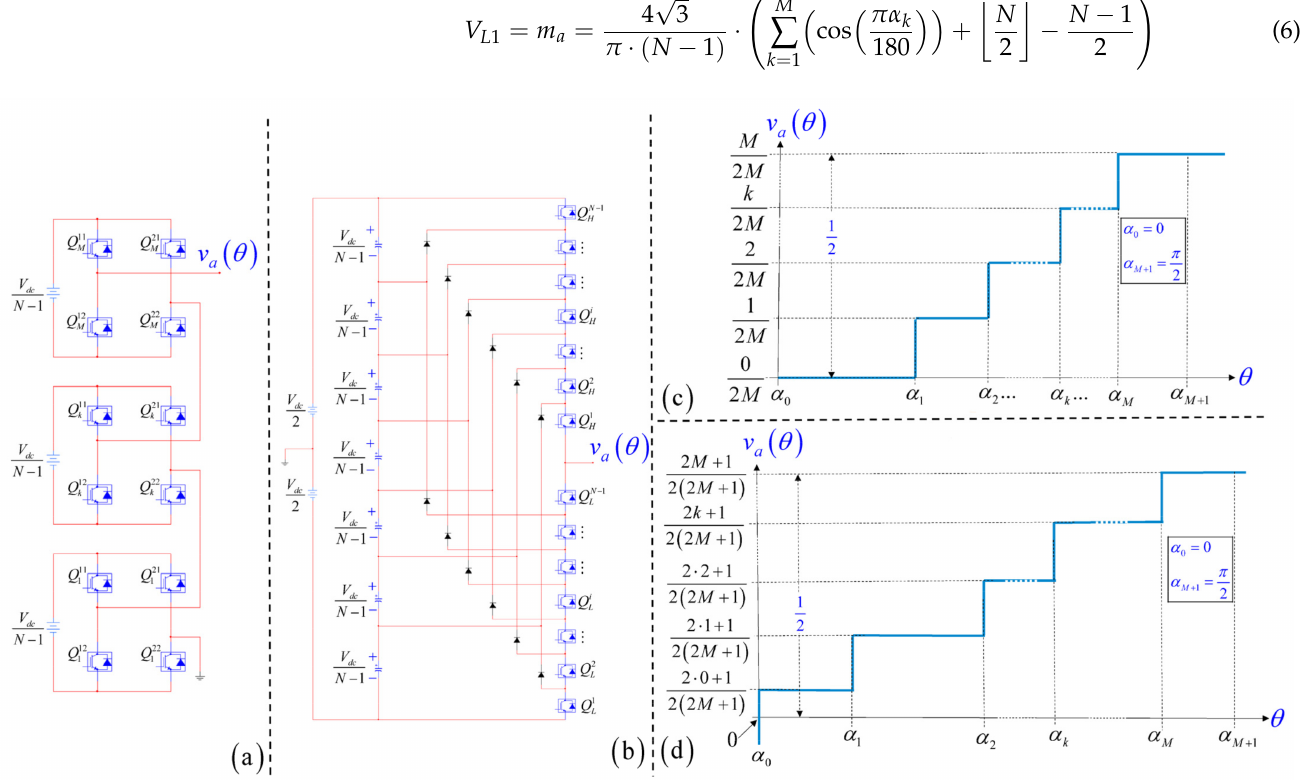
Figure 1. Generic MLI phase-leg: ( a ) cascaded H-bridge, ( b ) diode-clamped, and normalized odd quarter-wave symmetry SCM waveforms for: ( c ) odd-N case, and ( d ) for the even- N